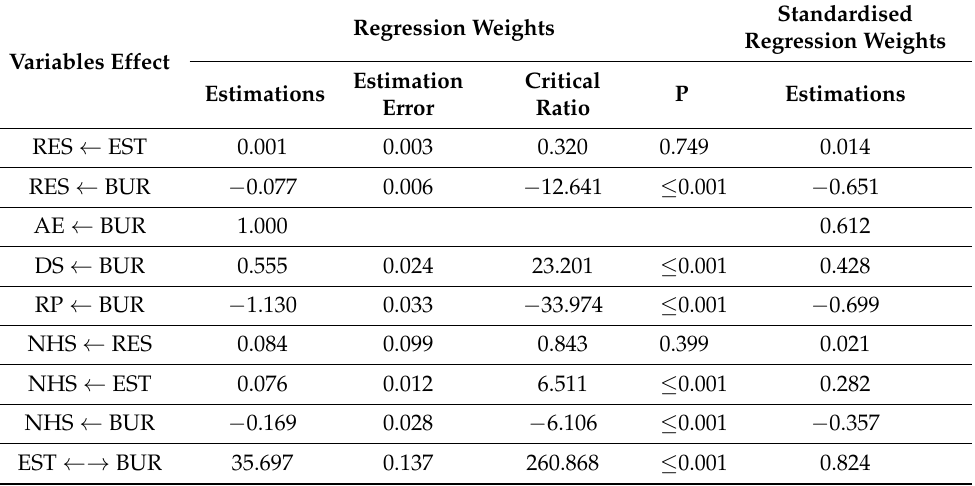
Table 4. Results of the structural